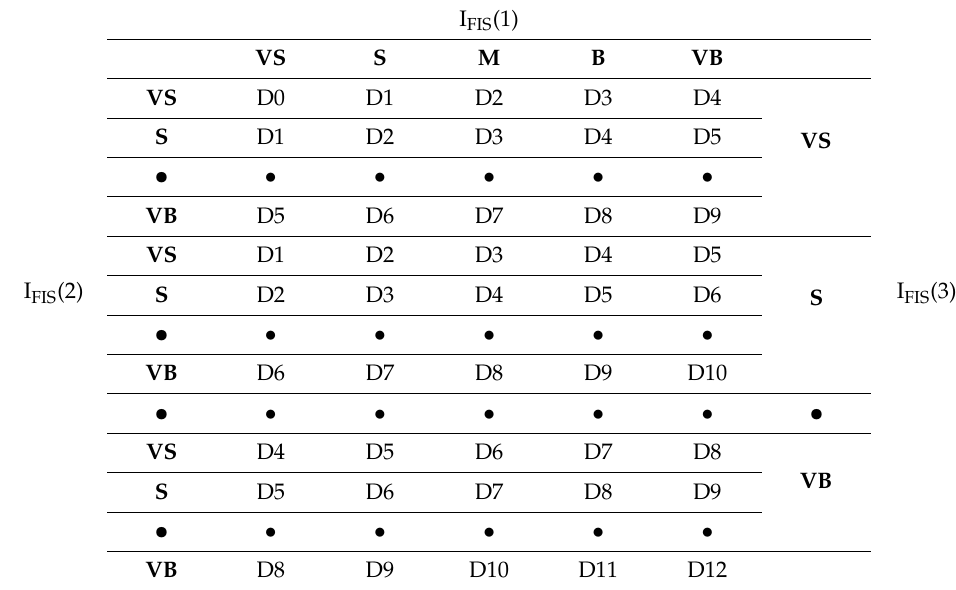
Table 1. A cross-section of the rules used to combine ML-based